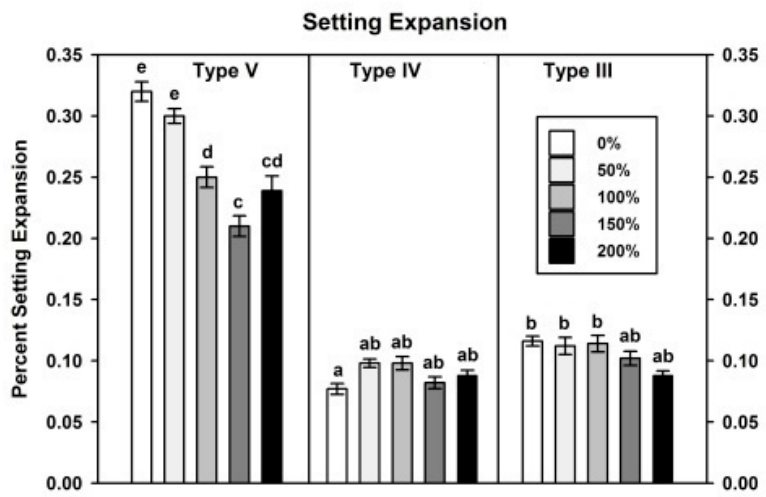
Figure 1. Bar chart of 72 h linear setting expansion for three gypsum types and five water dilutions. Error bars represent standard errors of means; groups with different letters are significantly different at α = 0.05 confidence level. Comparisons are both within and across gypsum types.